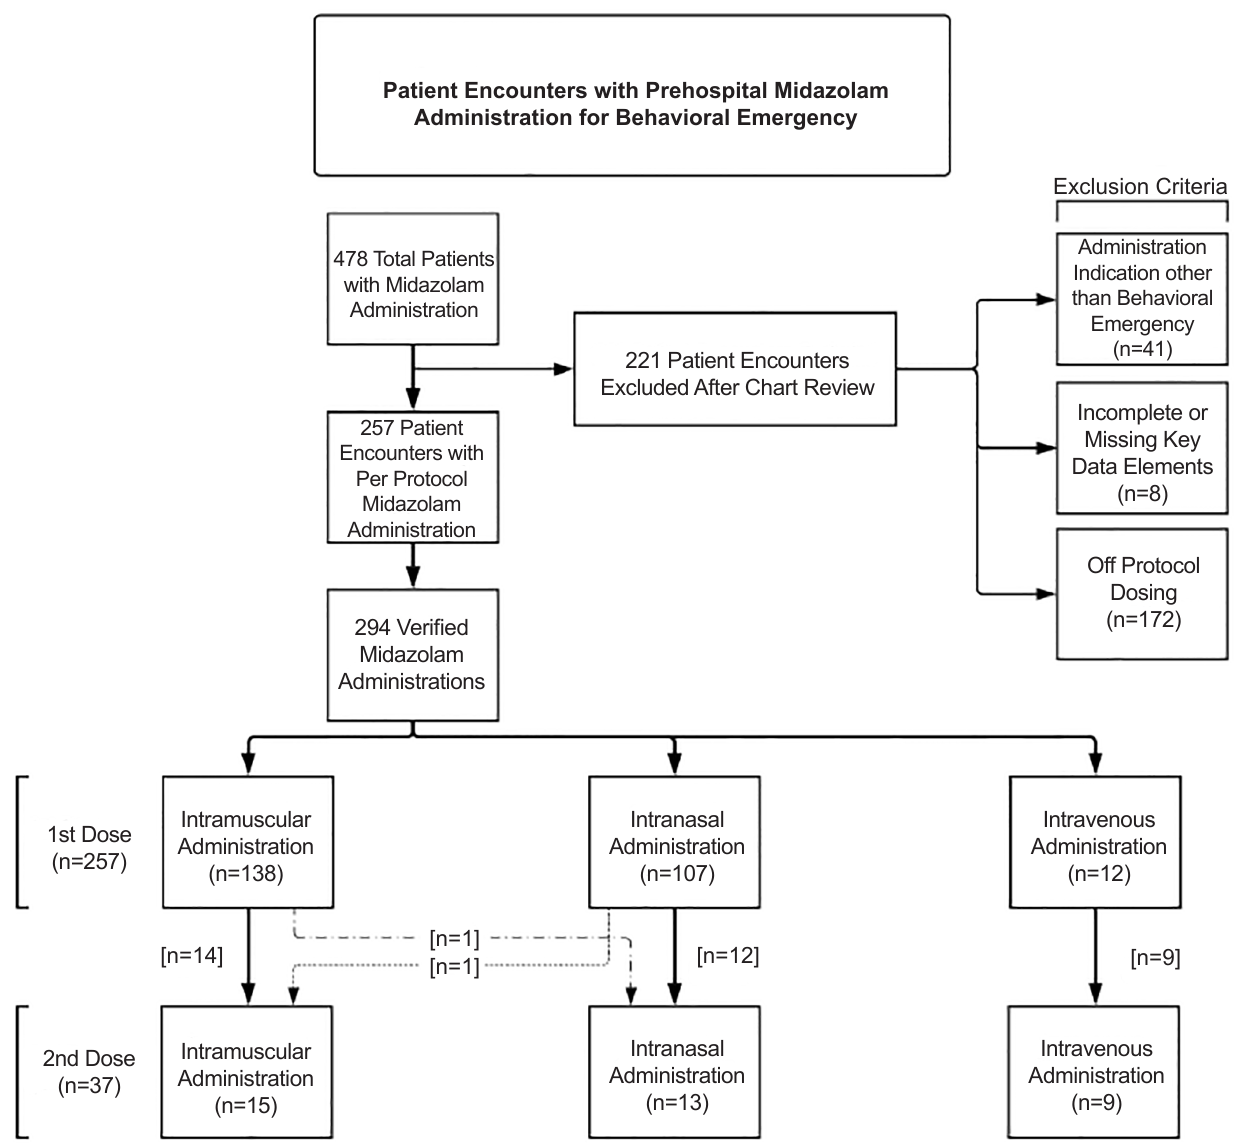
Figure 1. Patient encounters reviewed for midazolam administration in